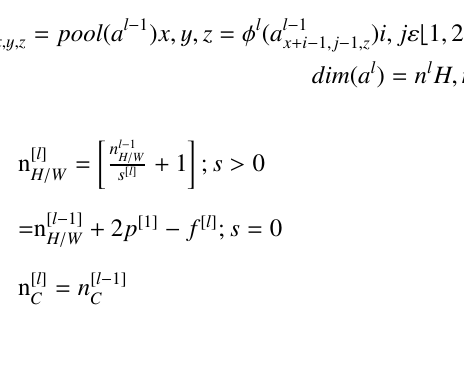
1. Deep-Fake Detection Dataset (DFD): This is